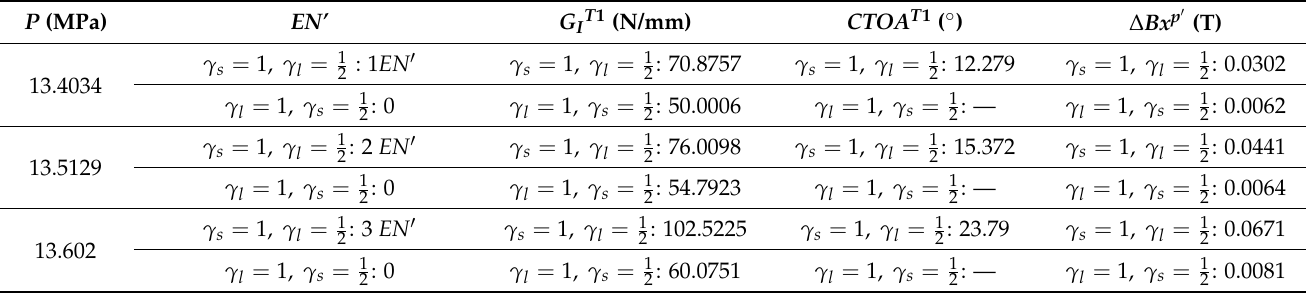
Table 9. Changes of the interference parameters 𝛾 examples. Table 8. Changes of the interference parameters γ l and γ s for the second set of the simulation examples.